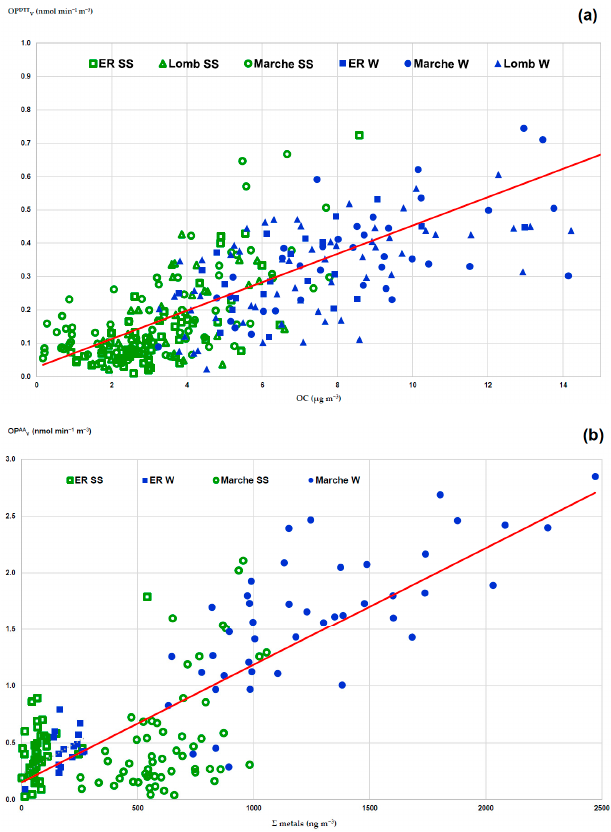
Figure 4. Relationship of the volume-normalized OP V responses with concentration of emission trac- ers for filters collected at various sites across Po Valley in different seasons. ( a ) dependence of the